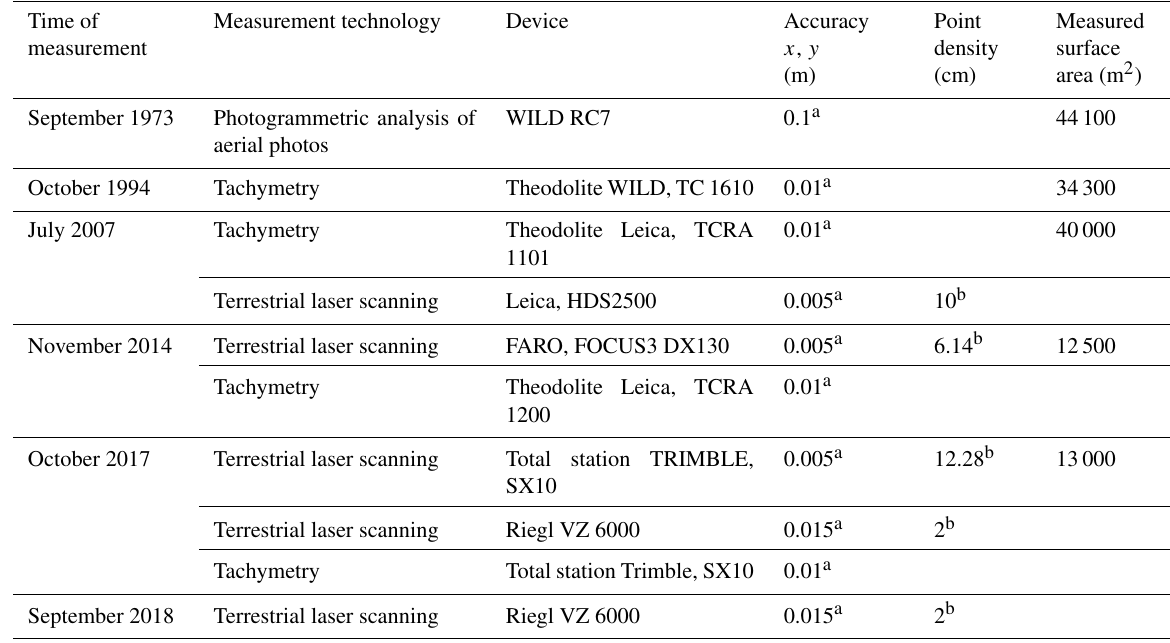
Table 1. Overview of remote-sensing measurements applied at the Ice Chapel since 1973. Time of